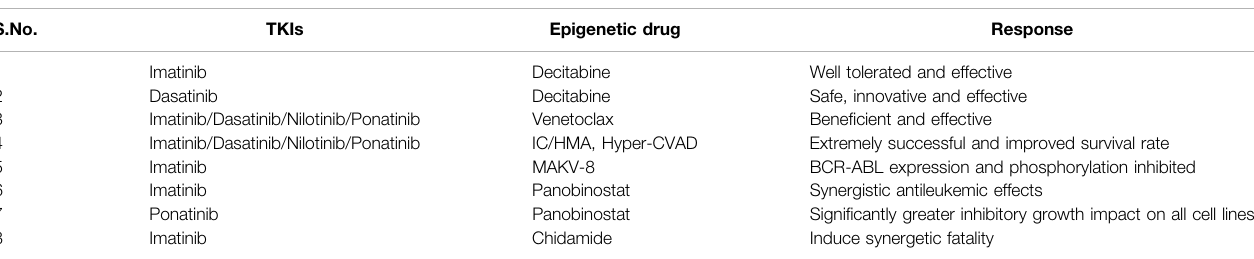
TABLE 4 | The combination therapy for CML using TKIs with epigenetic drugs.